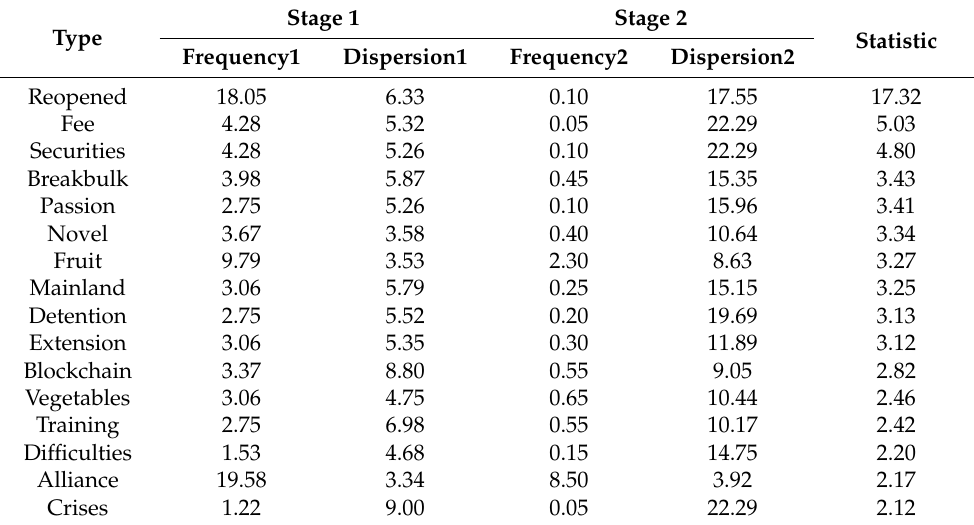
Table 4. Positive keywords for Stage 1 to Stage 2.